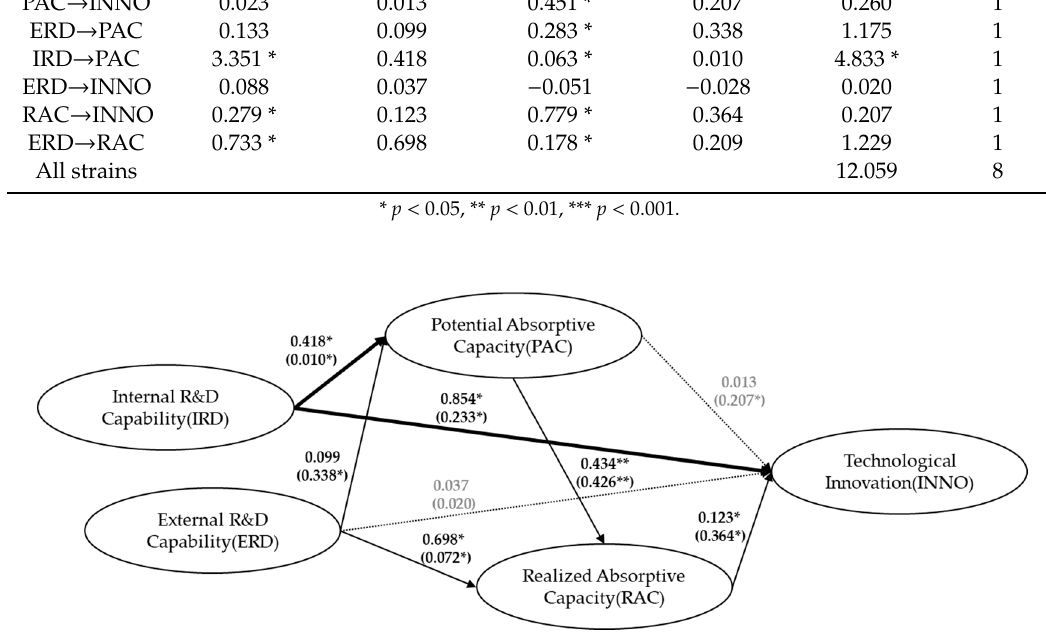
Figure 5. Structural model according to the high-tech and low-tech sectors. High-tech (Low-tech), * p < 0.05, ** p < 0.01, *** p < 0.001. Bold Line: Paths that differ in path coefficients between two sectors, Normal Line: significant path, Dotted Line: non-significant path.